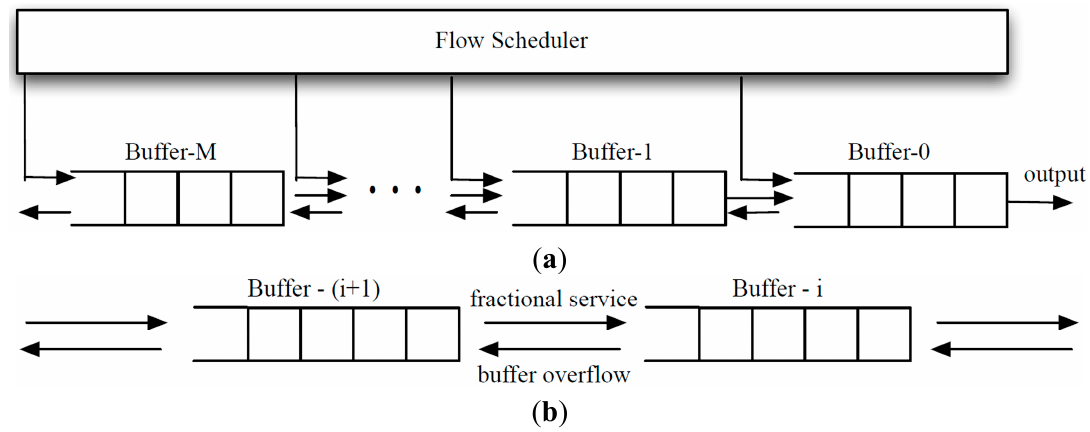
Figure 2. ( a ) Packets are assigned to different buffers in accordance with their delay classification; ( b ) Packet movements between buffers as directly by the FSA.